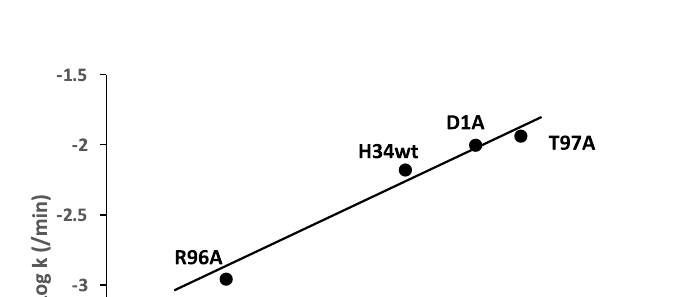
Table 2. Affinity constants obtained by two methods.